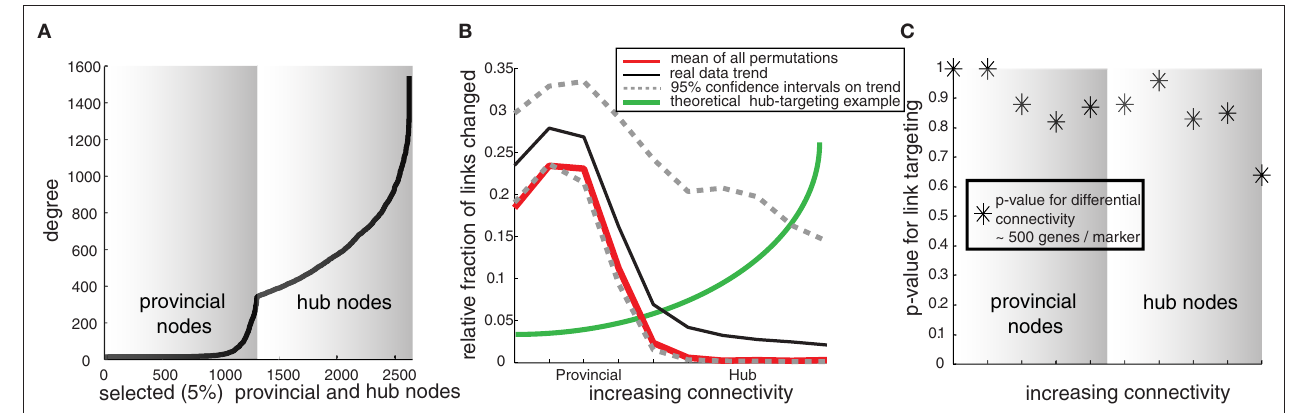
network comparisons with no disease effect). These permutations establish the mean and expected confidence bounds on a real effect. While provincial nodes are generically more likely to show differential connectivity compared to hub nodes, this is not a disease effect, but rather due to the greater statistical stability of hub nodes with a large base of connections, since the “real” network connectivity changes are within the expected bounds of variability. (C) To further quantify panel 3B, the p -values for probability of greater than expected differential connectivity are plotted, showing that connectivity changes in depression are not greater than expected by chance for both provincial and hub